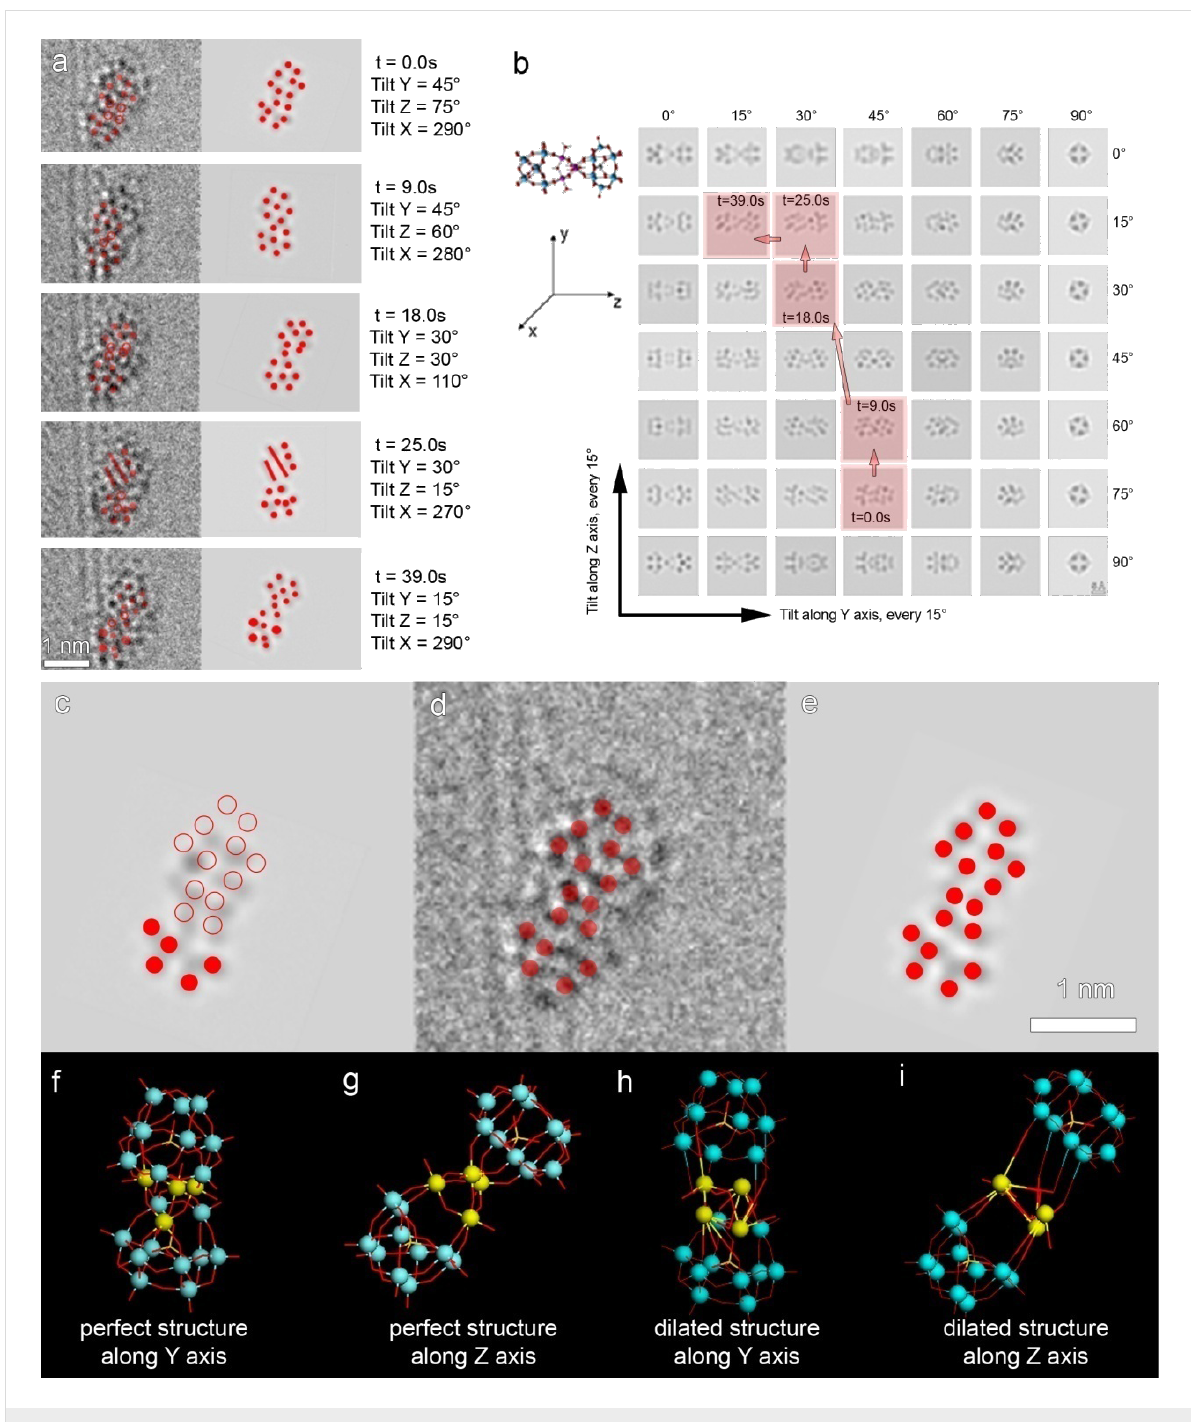
Figure 8: Dynamic study of Ru 4 POM functionalized on graphene. (a) Projections from a time sequence of functionalized Ru 4 POM together with their corresponding orientations determined from (b). (b) A plot summarizing simulated projections of an ideal Ru 4 POM molecule when tilted around the X and Y axes. The orientation changes from (a) are matched to the simulated patterns and highlighted by the red squares. (c) Simulated pattern of a Ru 4 POM whose orientation is found to fit into the HRTEM image shown in (a). The solid dot represents the fitted position of W, whereas the circle reveals a mismatch of the simulation and acquired pattern. (d) The acquired HRTEM image of Ru 4 POM to be fitted into the simulation shown in (c), where the position of W and Ru are indicated by solid red dots. (e) A simulated pattern of the dilated Ru 4 POM based on the scheme proposed in (c) with a distorted Ru 4 core. The fitted dots of Ru and W are indicated by solid red dots. (f) The scheme of a perfect Ru 4 POM with viewing direction along Y axis and (g) along Z axis. (h) The scheme of the dilated Ru 4 POM based on the perfect structure shown in (f) and (g) with a manually distorted Ru 4 core viewed along Y axis (h) and Z axis (i); reproduced with permis- sion from [112], Copyright (2013) John Wiley and